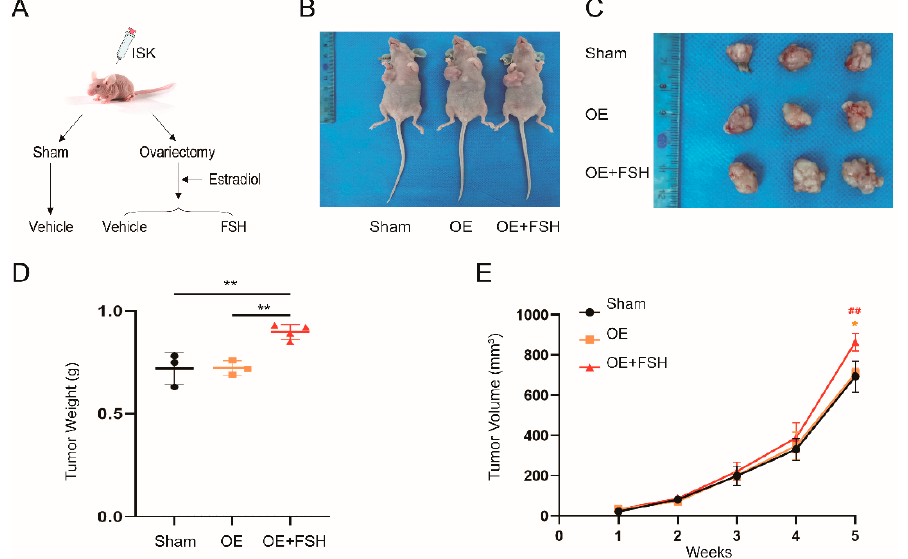
Figure 4. Effect of FSH on the neoplasia of endometrial cancer in nude mice. ( A ) Process diagrammatic drawing of BALB/c mice receiving different treatments. After acclimatization for one week, ISK cells were injected into the left axilla (approximately 1 × 10 7 /0.2 mL) of the mice. Three groups of mice were randomly assigned: (1) sham surgery (sham), (2) bilateral ovariectomy (OVX) with dietary estradiol (E2) supplementation (OE), and (3) OVX plus E2 with FSH (30 IU/(kg, d)) (OE plus FSH). Group (1) received a vehicle injection and was used as the control. Group (2) was given desiccated E2 powder (2.6 ppm) as a hormone replacement diet supplement to eliminate the impact of E2. Group (3) received FSH intravenously and daily for two weeks until ( B ) the mice were killed. ( C ) Tumors from the mice were collected and ( D ) weighed. ( E ) Weekly growth curves of the tumors and tumor volumes. The formula used was: volume = (π × length × width (cid:2870) ) ∕ 6 . Data are expressed as means ± SDs. ** p < 0.01 and * p < 0.05 versus the sham group, and ## p < 0.01 versus the OE group .